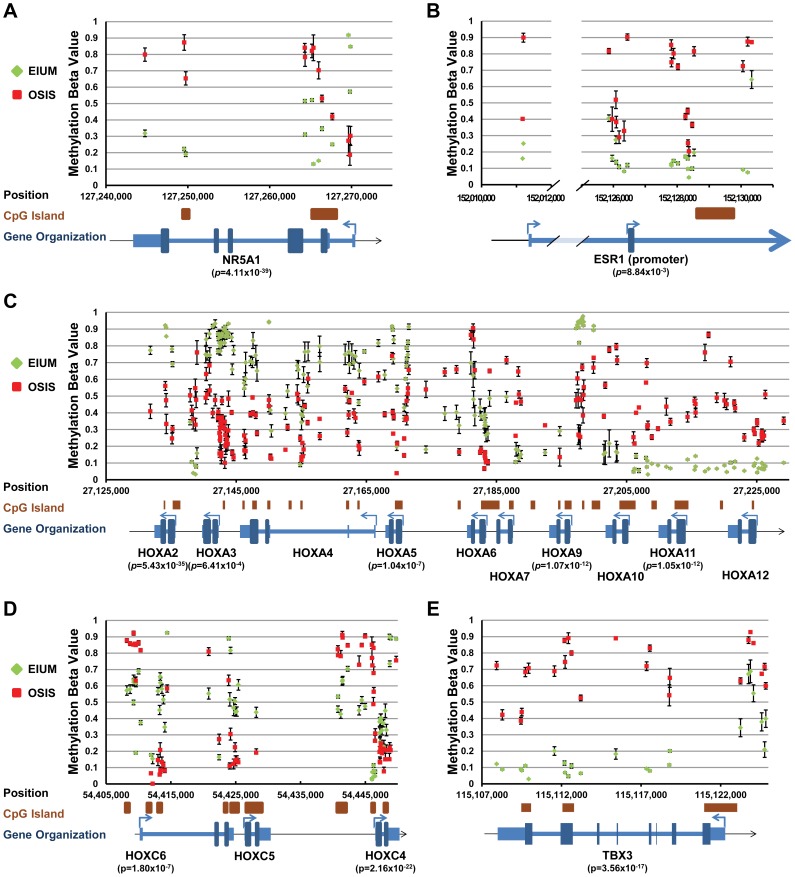
Key transcription factors with differential methylation (part 1).Methylation maps for the following five genes/genomic regions show the differentially methylated CpGs identified by ANOVA interaction analysis: (A) NR5A1; (B) ESR1 promoter regions; (C) portion of the HOXA cluster; (D) portion of the HOXC cluster; (E) TBX3. Each plot shows the average β-value for untreated EIUM (green diamond) and OSIS (red squares) at the genomic coordinate for each identified CpG (error bars show SEM). CGI's and gene diagrams are illustrated below each plot. (When significant, the lowest p-value obtained from the ANOVA interaction is shown below gene symbols.)